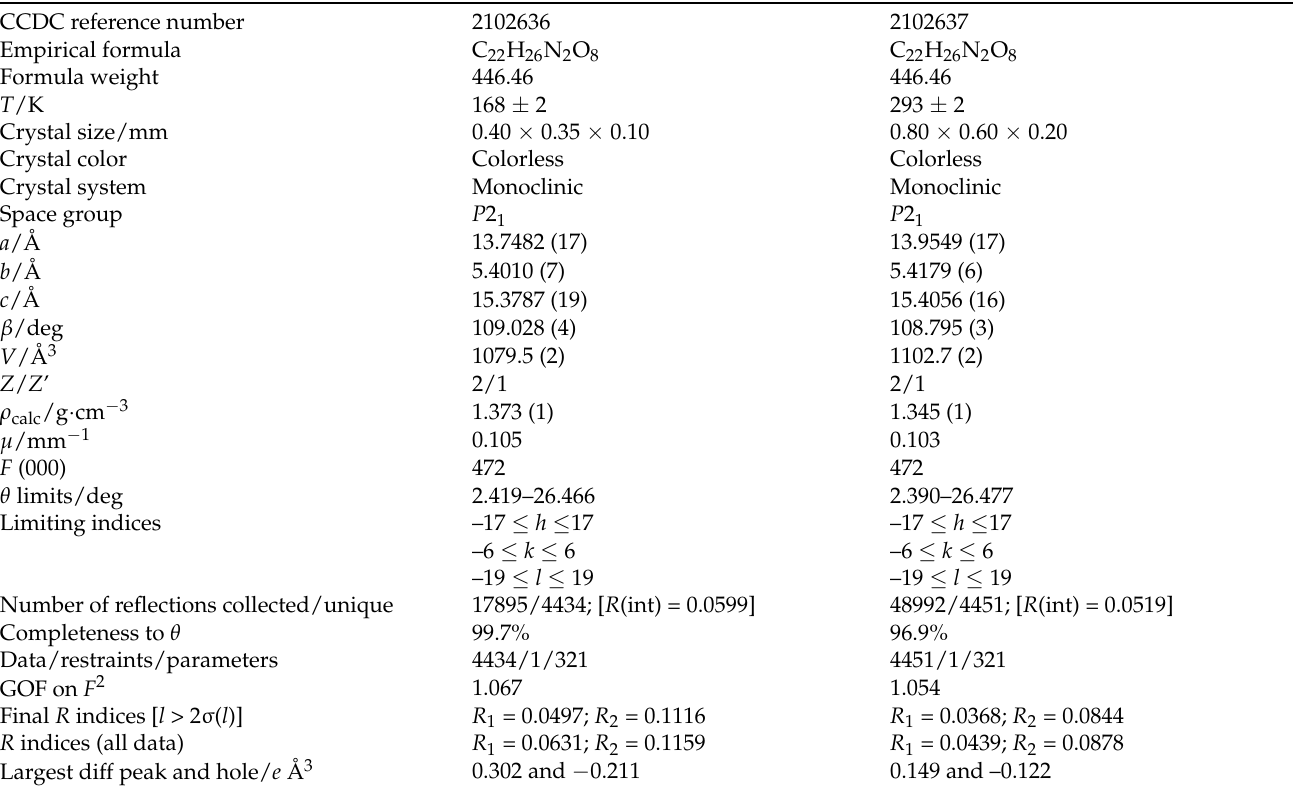
Table 5. Crystal data and structure refinement parameters for MA:Phe 2